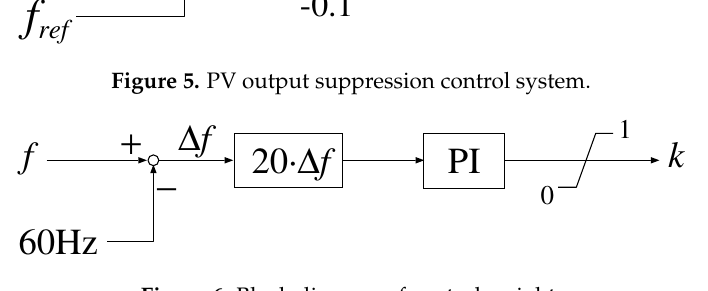
Figure 6. Block diagram of control weight.